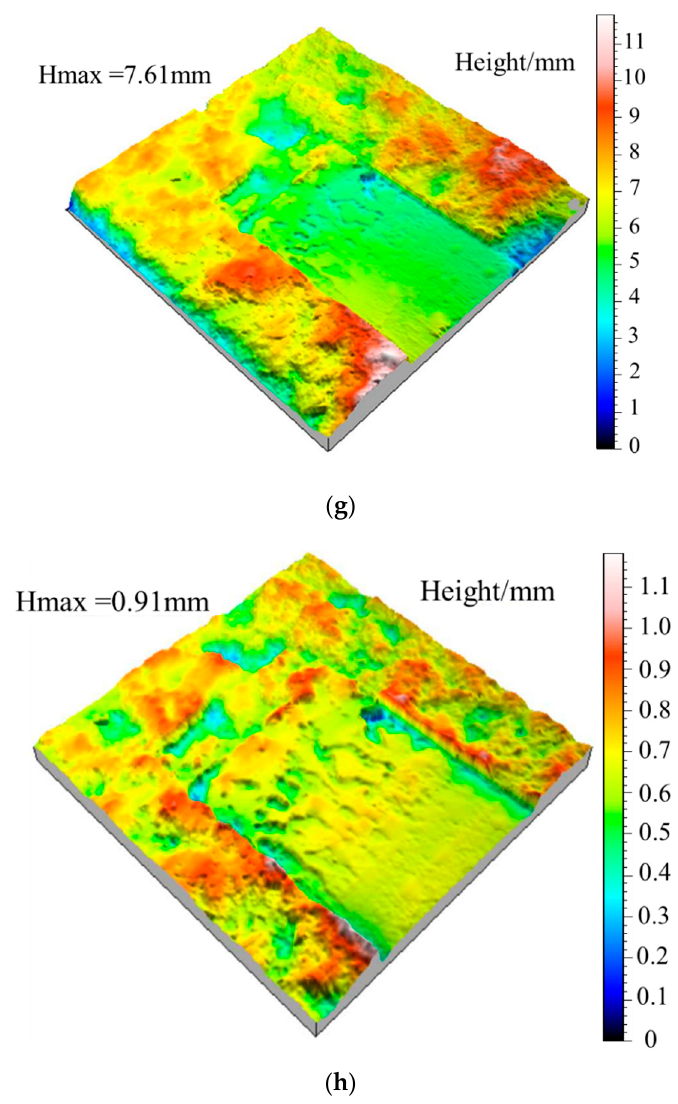
Figure 11. Three-dimensional topography of waviness and unevenness of jointed rock specimen after the second shear test under freeze-thaw cycles. ( a ) The waviness morphology of specimen after ten freeze-thaw cycles. ( b ) The unevenness morphology of specimen after ten freeze-thaw cycles. ( c ) The waviness morphology of specimen after 20 freeze-thaw cycles. ( d ) The unevenness morphology of specimen after 20 freeze-thaw cycles. ( e ) The waviness morphology of specimen after 30 freeze-thaw cycles. ( f ) The unevenness morphology of specimen for 30 freeze-thaw cycles. ( g ) The waviness morphology of specimen after 40 freeze-thaw cycles. ( h ) The unevenness morphology of specimen after 40 freeze-thaw cycles.